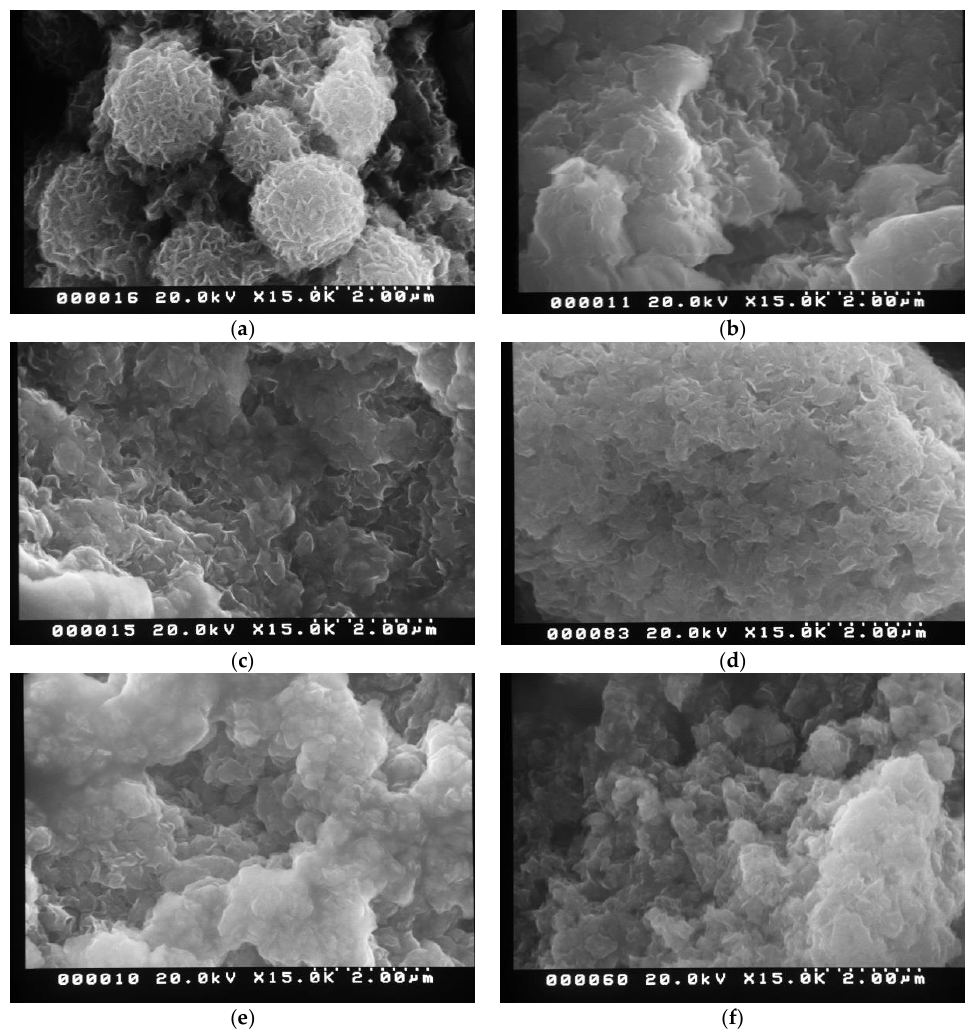
Figure 3. SEM images of Zn (1−2x) (CuGa) x In 2 S 4 . ( a ) x=0, ( b ) x = 0.07, ( c ) x = 0.10, ( d ) x = 0.13, ( e ) x = 0.16, and ( f ) x = 0.19.